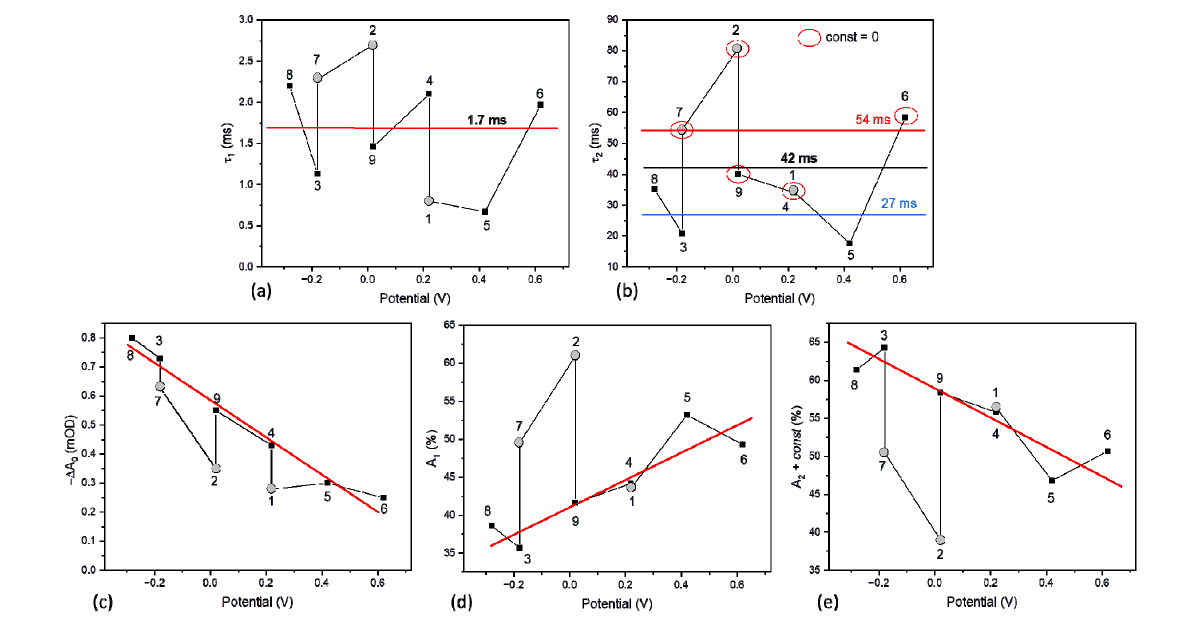
Figure 9. Dependence of bi-exponential fit parameters on voltage applied to the PSI-FTO electrode (with no chemicals added; experiments no. 1–9 in Table 1). ( a ) Lifetime τ 1 with the average value indicated; ( b ) lifetime τ 2 with the average values indicated separately for the kinetics fitted with const = 0 (54 ms; points in the red ellipses), const ≠ 0 (27 ms; remaining points), and for all kinetics (42 ms); ( c ) initial amplitude, −Δ A 0 ; ( d ) amplitude A 1 of the fast phase (~1.7 ms); ( e ) the sum of the amplitude A 2 of the slow phase (~42-ms) and const parameter. The points shown as gray circles (1, 2, 7) are those for which the initial amplitude ( −Δ A 0 ; panel ( c )) deviates from the general trend due to specific sequence of the applied potentials. The red lines in panels c-e indicate trends in the values of the amplitudes with neglected points 1, 2, and 7.